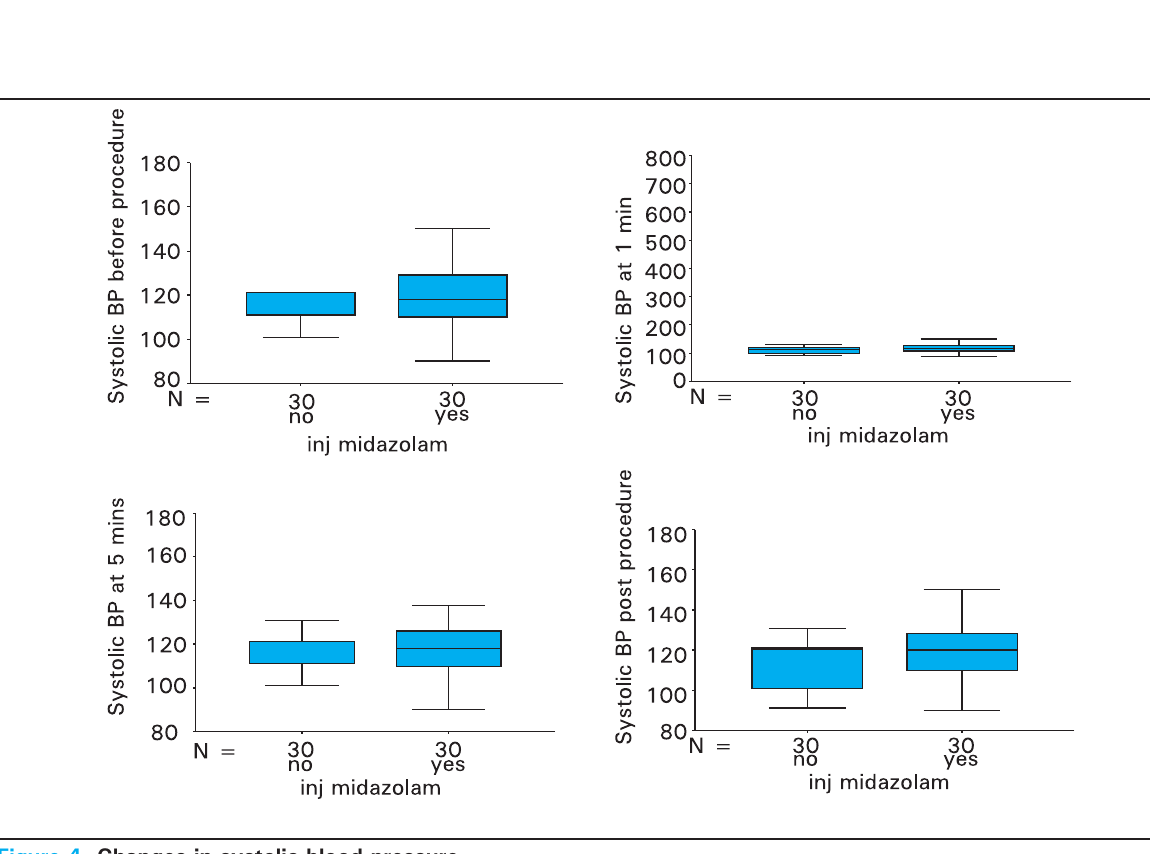
Figure 4. Changes in systolic blood